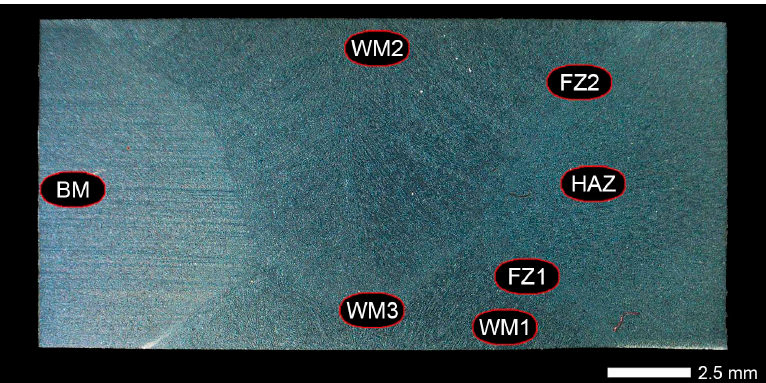
Figure 5. Macroscopic image of cross-section of a Hardox Extreme welded joint after welding. WM— weld metal zone, FZ—fusion zone, BM—base material zone, CGH(AZ)—coarse-grained heat-affected zone (overheating), FGH(AZ)—fine-grained heat-affected zone (normalization and recrystallisation), ICH(AZ)—intercritical heat-affected zone (incomplete normalization). Stereoscopic microscopy, etched with 3% HNO3 and Adler’s etchant.